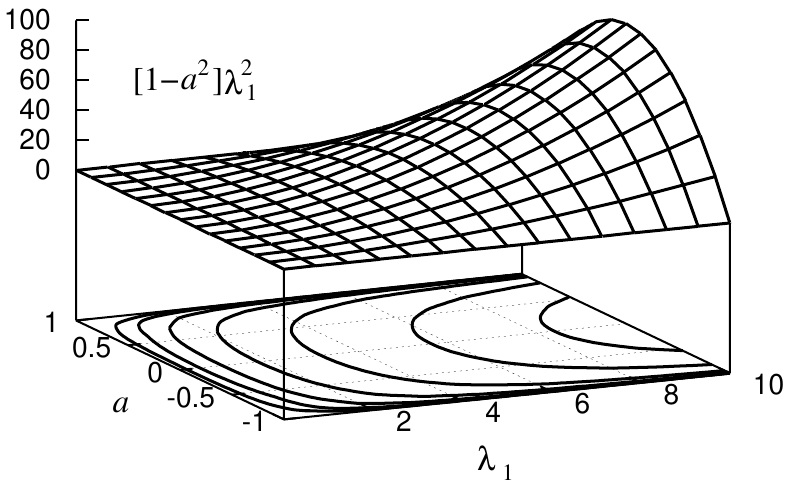
(cid:0) [ (cid:1) 1 − a 2 ] λ 2 as a function of a and λ 1 . 1